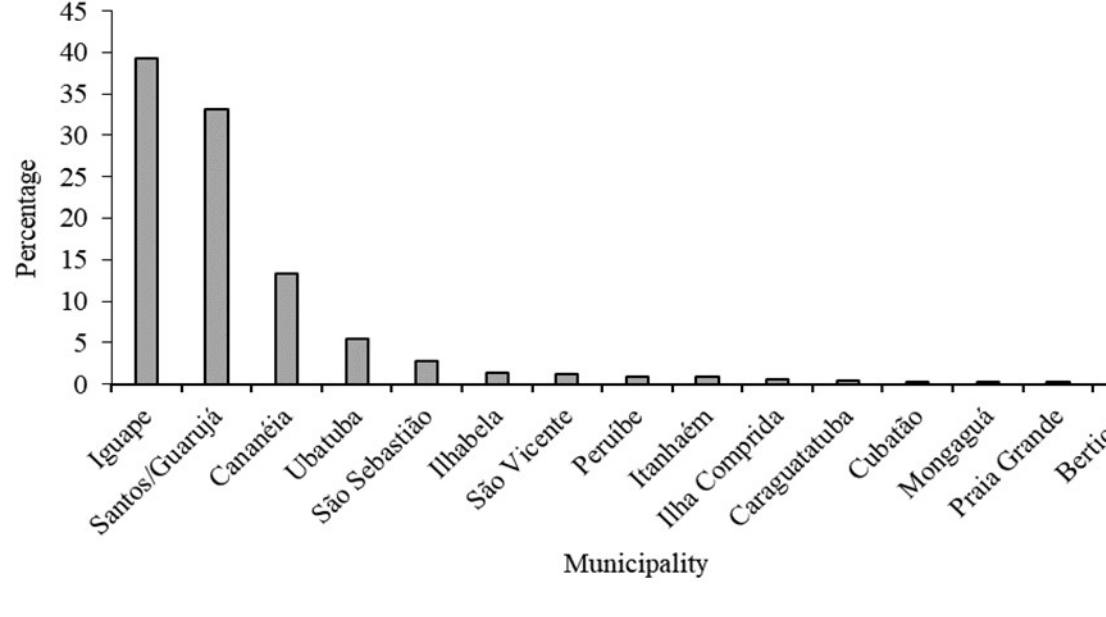
Figure 3. Municipal contribution in the landed volume of white catfish ( Genidens barbus ) from 2000 to 2014 on the coast of São Paulo.